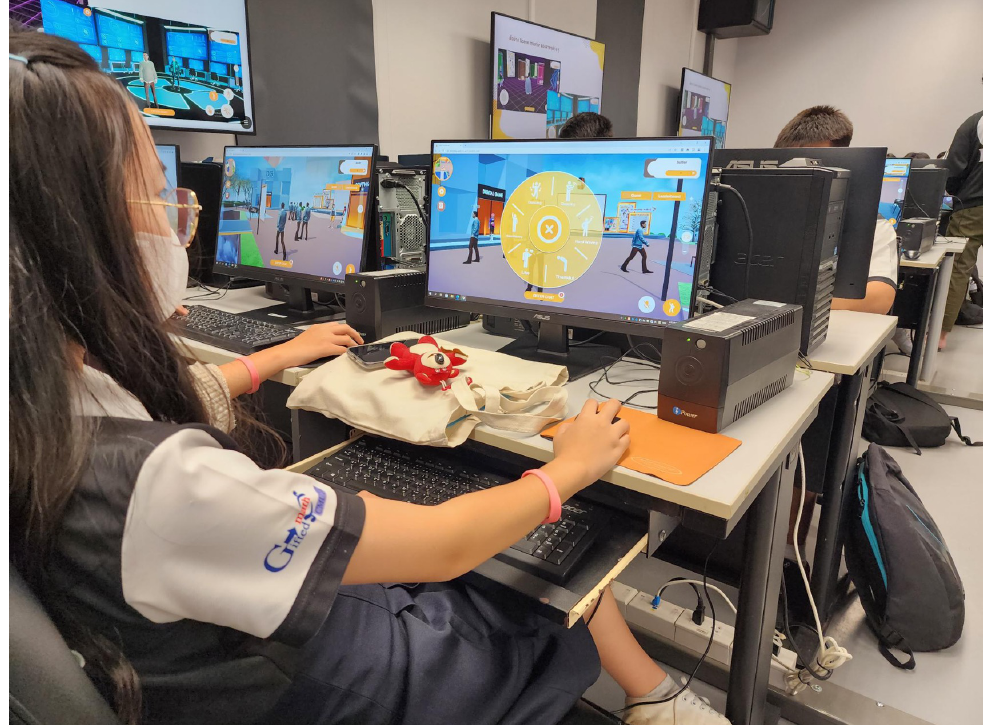
Figure 13. The participants used the metaverse platform in the computer laboratory during the open-house